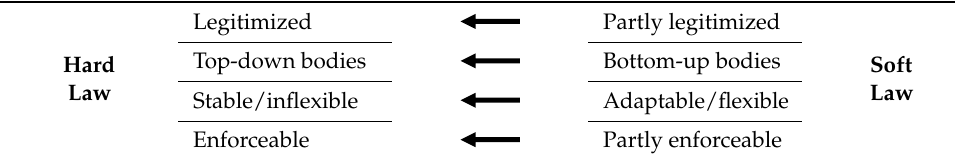
Table 1. Intermingling of the concepts of hard law and soft law.